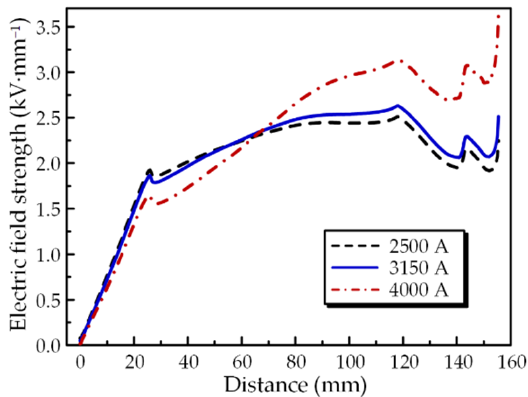
Figure 18. The influence of the load current on the electric field distribution of the spacer.